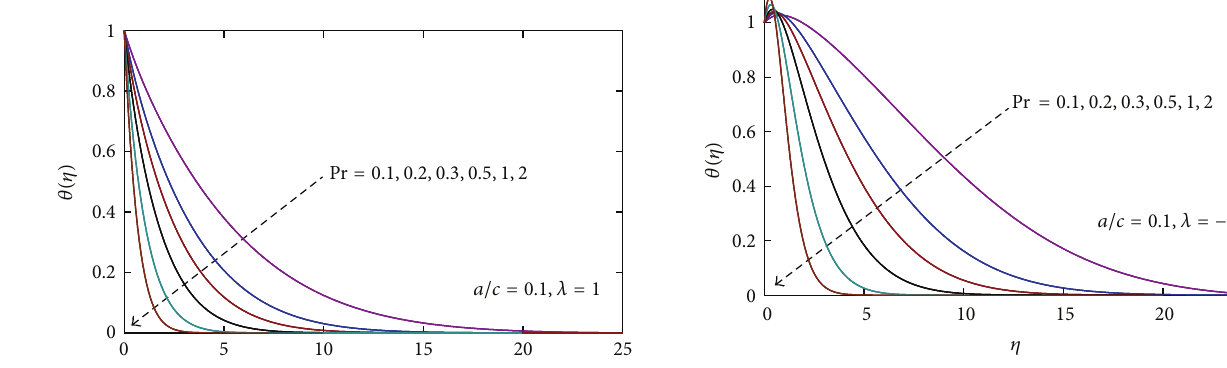
Figure 12: Temperature profiles 𝜃(𝜂) for various values of Pr with 𝑎/𝑐 = 0.1 and 𝜆 = −1.5